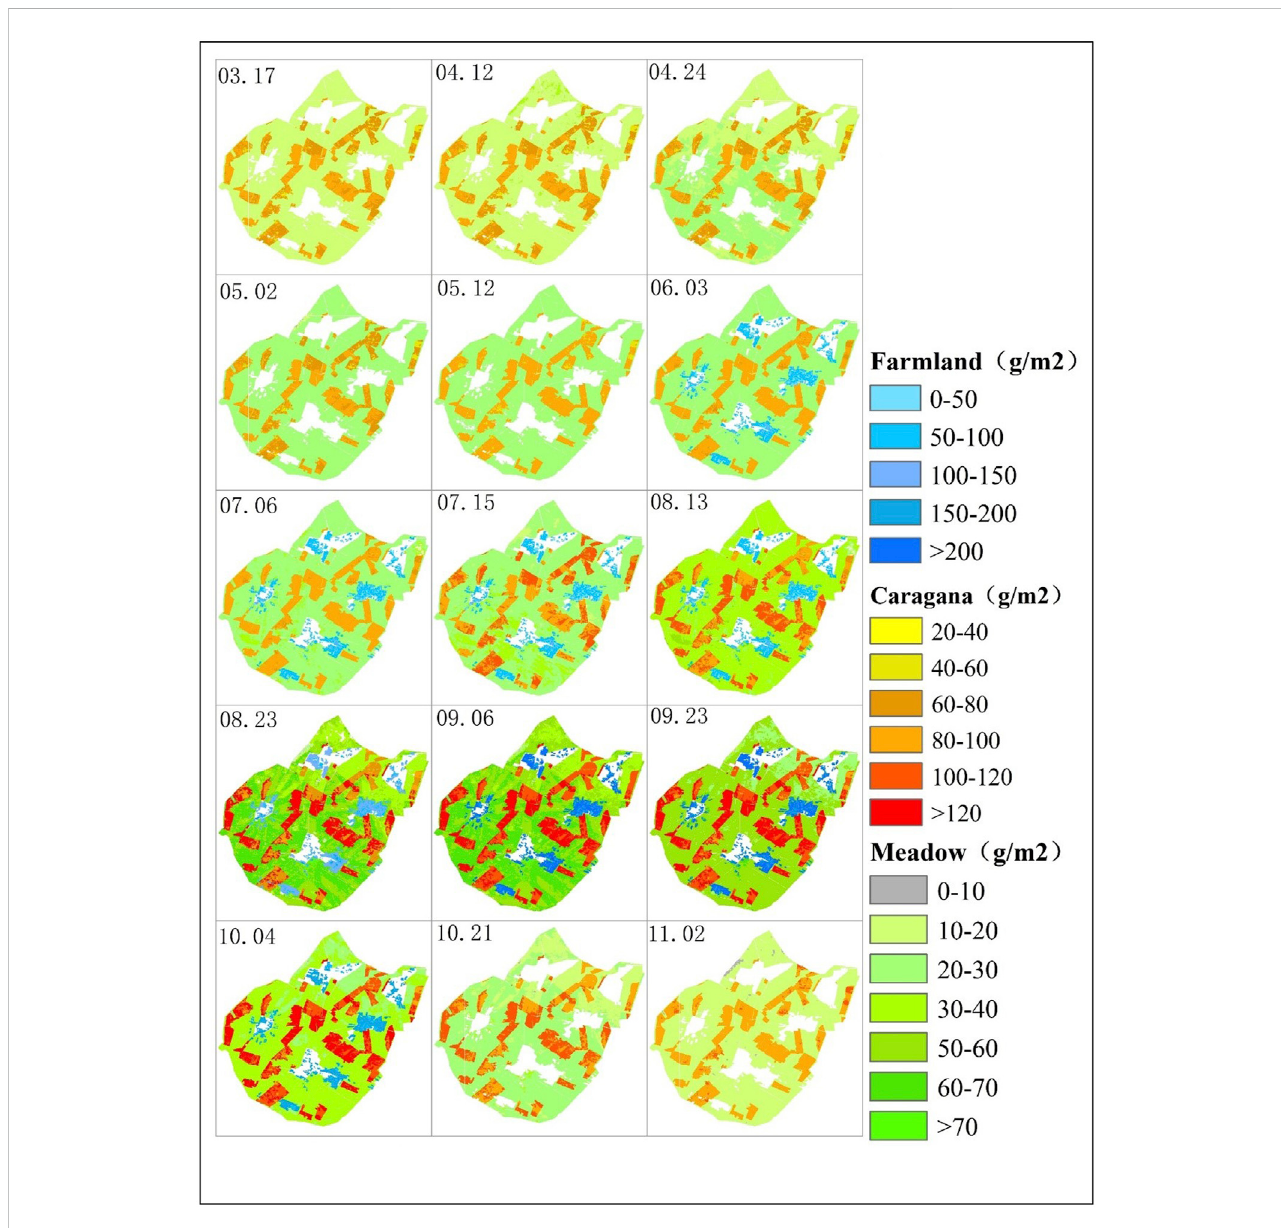
FIGURE 4 Time series diagrams of vegetation biomass in Wanjigou Village in